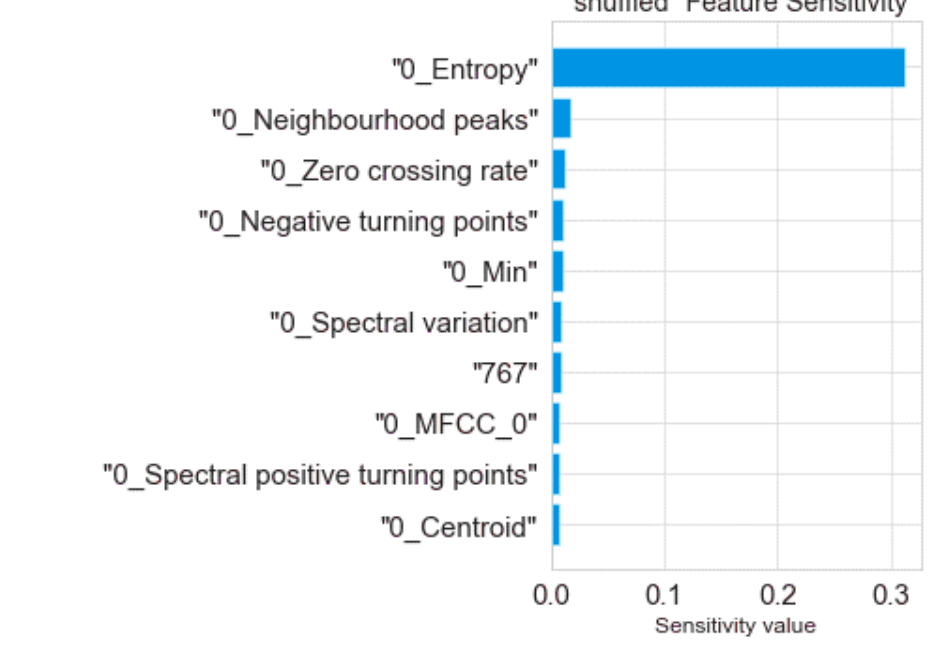
Figure 18. The sensitivity analysis of the proposed model.